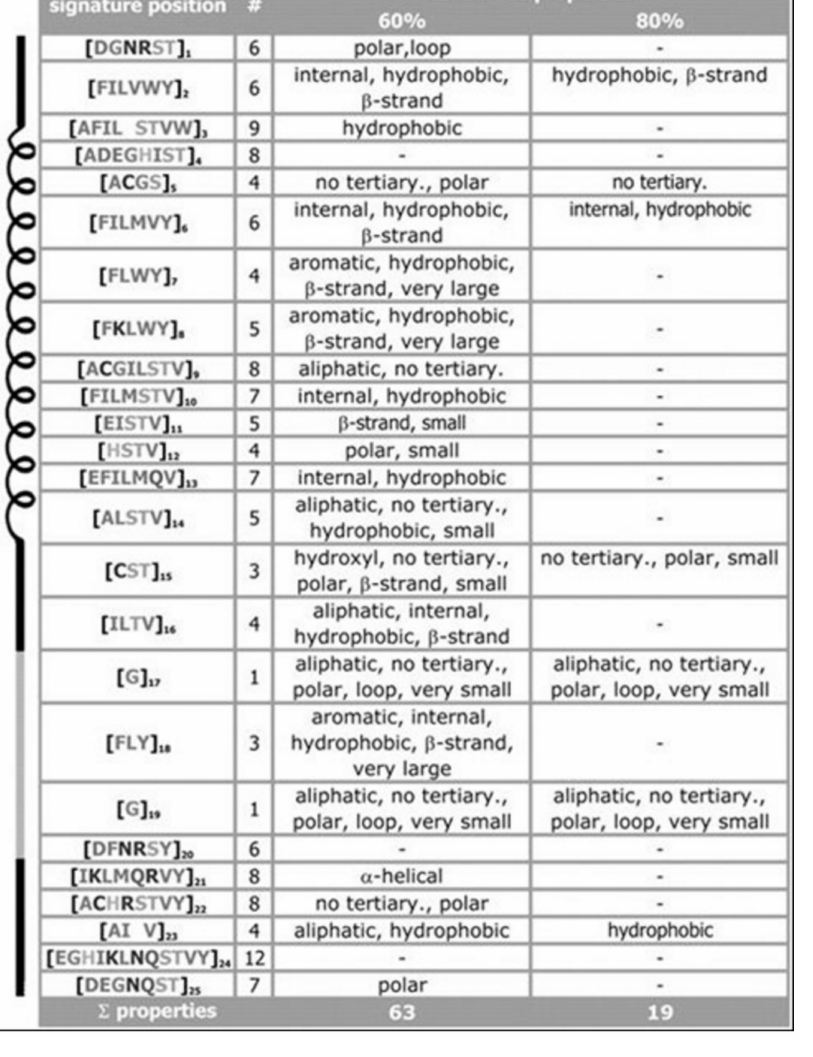
Figure 3. Property conservation at the 60 and 80% level of significance, respectively. Despite having low amount of amino acid conservations we find properties conserved in almost 80% sequences. From pores of the potassium channels, as expected, the hydrophobic residues are found to dominate in pore regions, a few polar residues decrease energetic barriers for K+ ions. Details in ref.